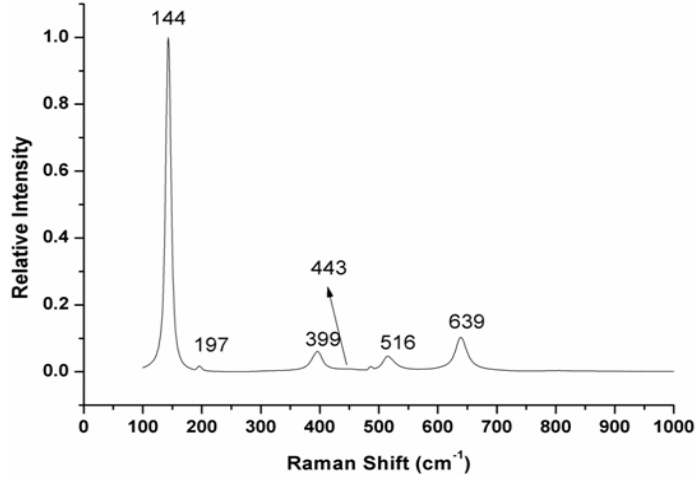
Figure 4. Raman spectrum of TiO 2 nanoparticles.